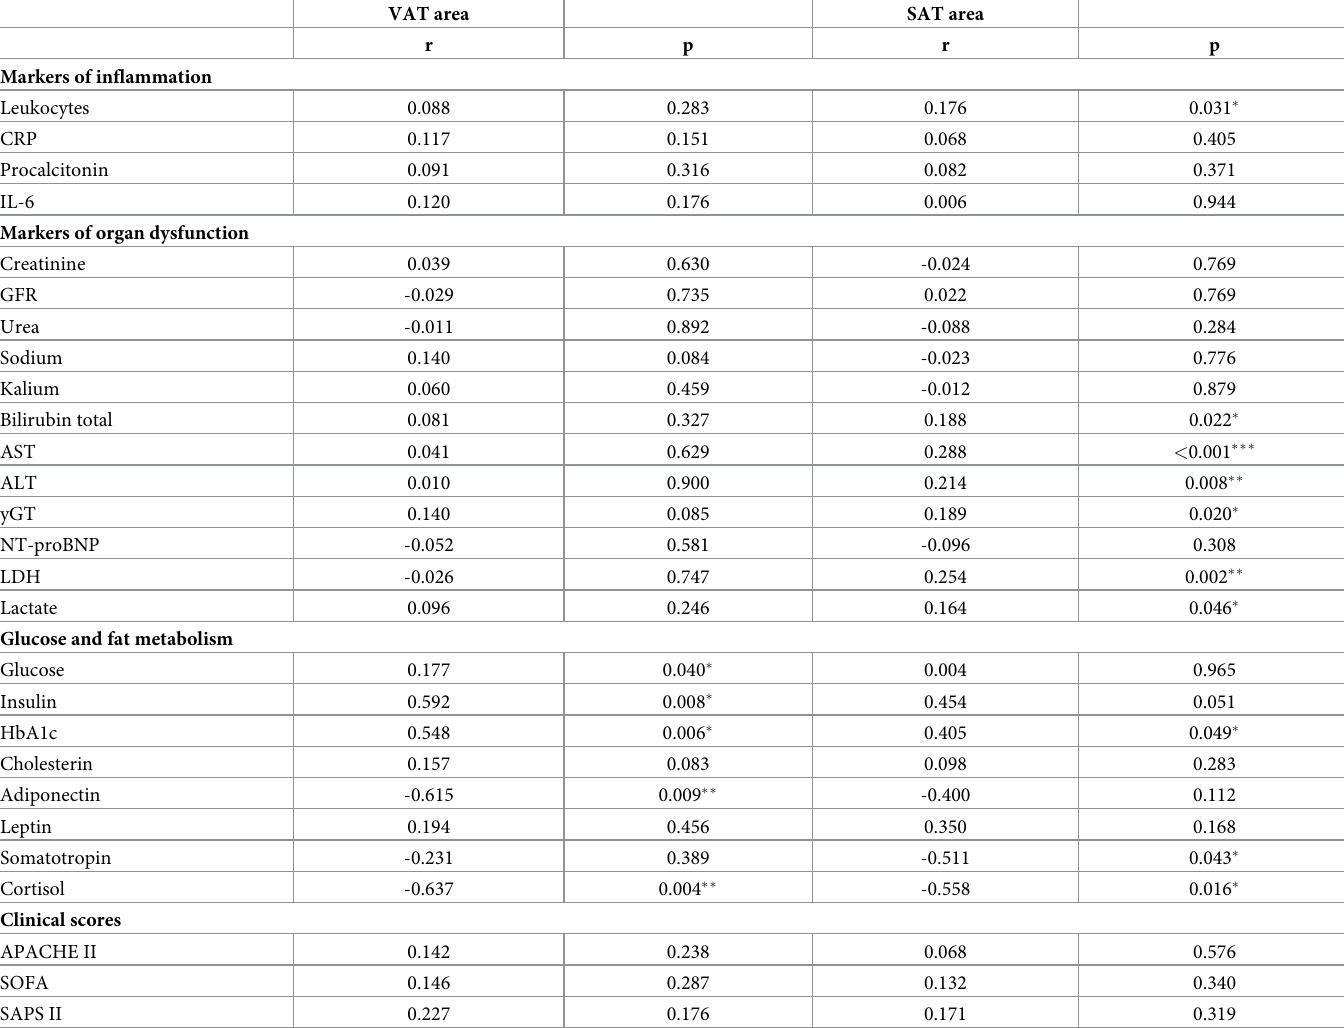
Table 2. Correlations of VAT and SAT area with markers of inflammation, markers of organ dysfunction, metabolic laboratory markers and clinical scores at day 1 of ICU